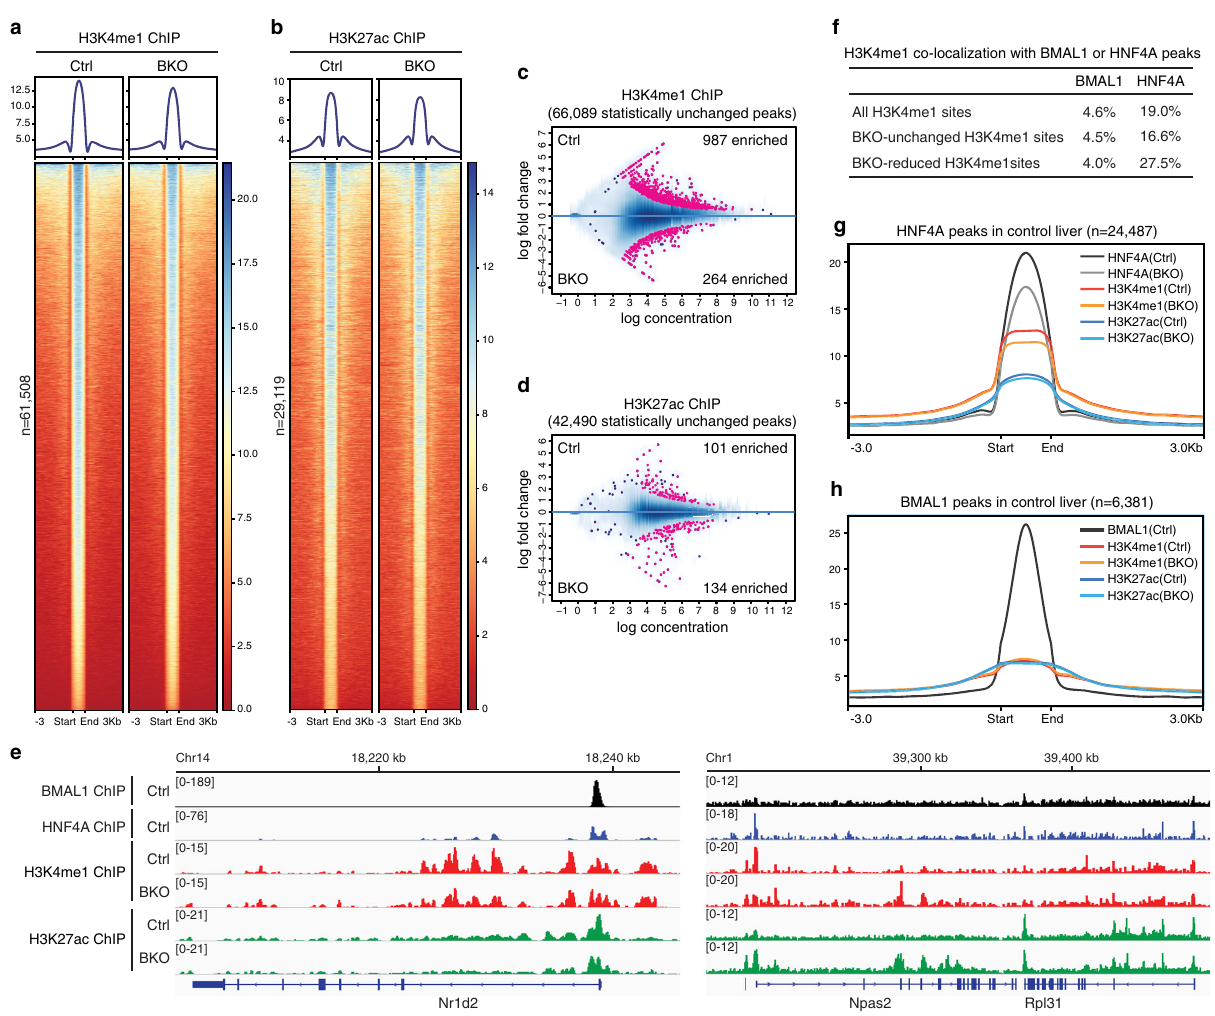
Fig. 7 Bmal1 knockout alters the epigenetic landscape in the liver, seemingly due to attenuated HNF4A activity. a , b Heatmap of H3K4me1 ( a ) or H3K27ac ( b ) ChIP-seq signals at ZT16 in control (left) or BKO (right) liver and centered at all peaks in control liver. Peaks are ordered vertically by signal strength. c , d MA plot showing differential H3K4me1 ( c ) or H3K27ac ( d ) peaks in control and BKO livers, using a threshold of FDR < 0.05. The x -axis represents the mean number of reads (log scaled) within the peaks across all samples. The y -axis represents the log fold change between the two samples. e IGV genome tracks showing BMAL1 (at ZT6), HNF4A (at ZT16), H3K4me1 (at ZT16), and H3K27ac (at ZT16) enrichment at Nr1d2 and Npas2 genes in control or BKO liver, based on normalized ChIP-seq read coverage. Track heights are indicated. f Percentages of three groups of H3K4me1 sites colocalizing with BMAL1 or HNF4A peaks. Peak numbers for percentage calculation are in Supplementary Fig. 12g, h. g Metaplot showing average intensity of HNF4A, H3K4me1, and H3K27ac ChIP-seq signals (all at ZT16) in control or BKO livers surrounding HNF4A peak centers in control liver. h Metaplot showing the average intensity of BMAL1 (at ZT6), H3K4me1 (at ZT16), and H3K27ac (at ZT16) ChIP-seq signals in control or BKO livers surrounding BMAL1 peak centers in control